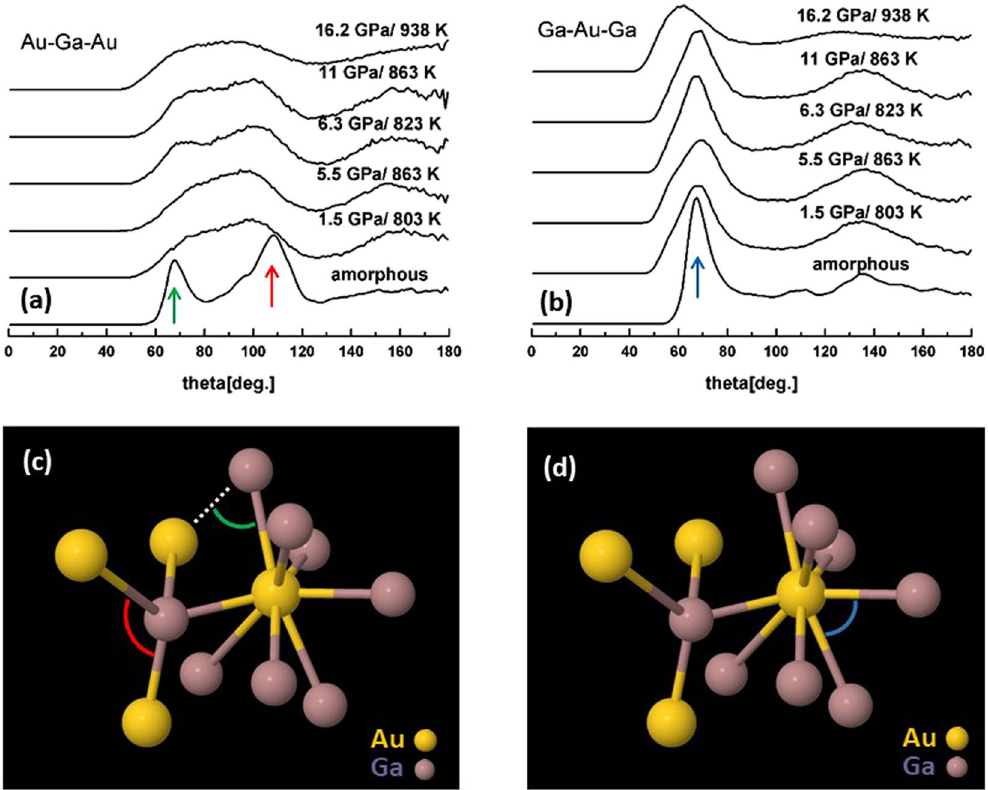
Figure 7. Au-Ga-Au ( a ) and Ga-Au-Ga ( b ) bond-angle distributions as functions of pressure, and structural motifs at zero pressure ( c , d ) captured from EPSR.